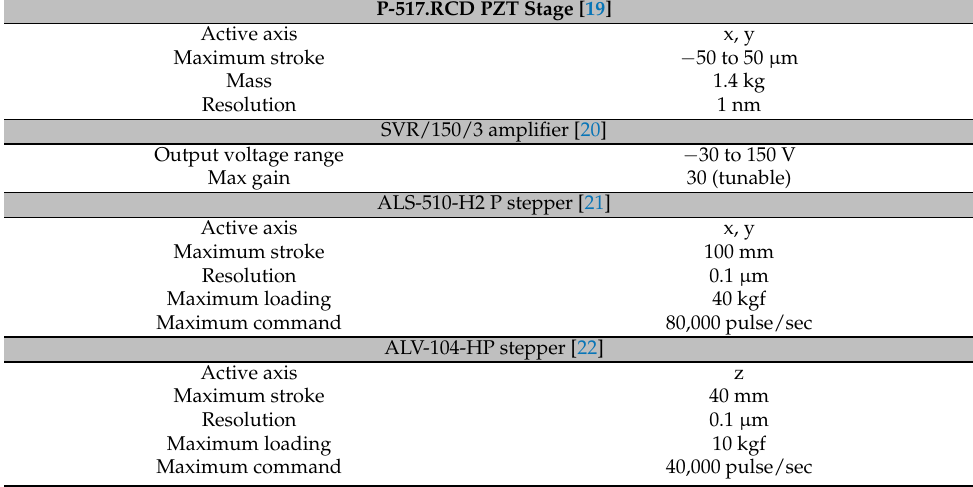
Table 1. Specifications of the long-stroke precision